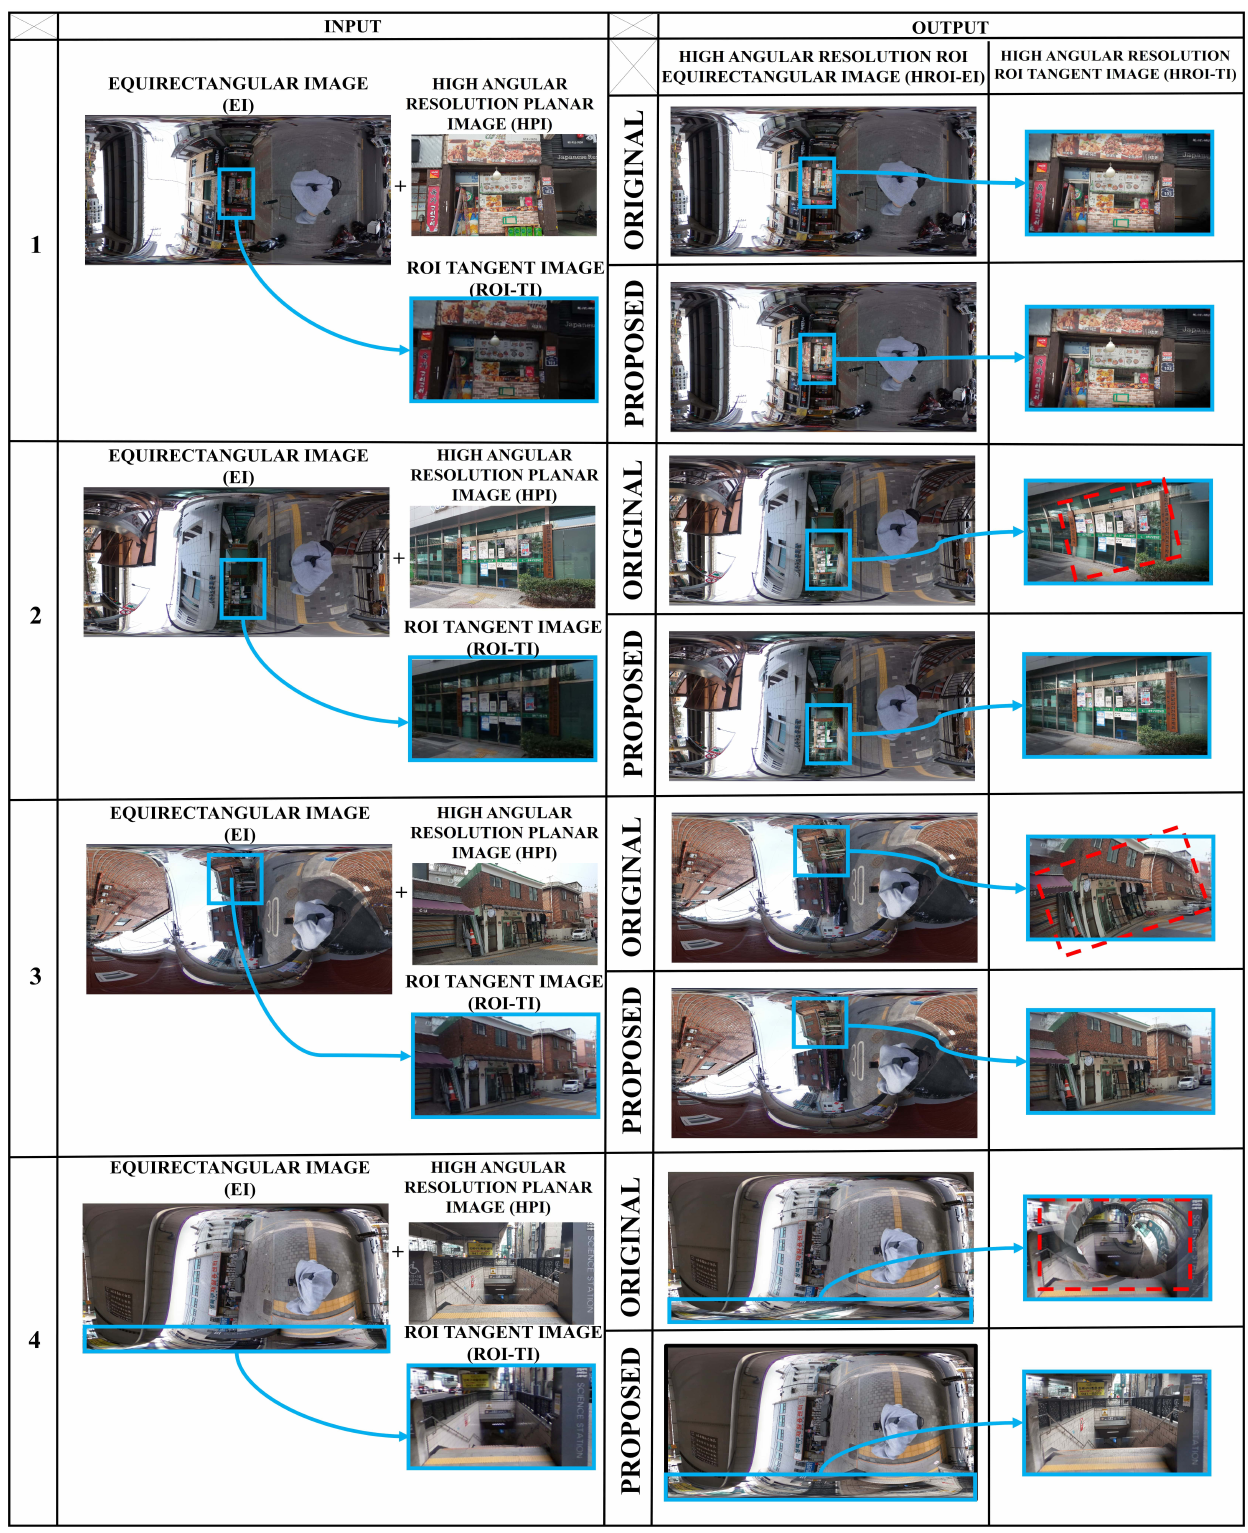
Figure 11. Visual comparison between high angular resolution planar image (HPI)-equirectangular image (EI) stitching (PROPOSED) with planar-planar image stitching (ORIGINAL). The dashed red line depicts distorted region. Both methods resulted in a pair of high-resolution ROI equirectangular (HROI-EI) and tangent images (HROI-TI). When the ROI is located around the EI central region (image no. 1), both methods result in similar results. As the ROI goes further from the center (image no. 2, 3, and 4), the proposed method results in a much less distorted image than the original one. Zoom in the image to see the resolution difference between the ROI tangent image (ROI-TI) with stitching